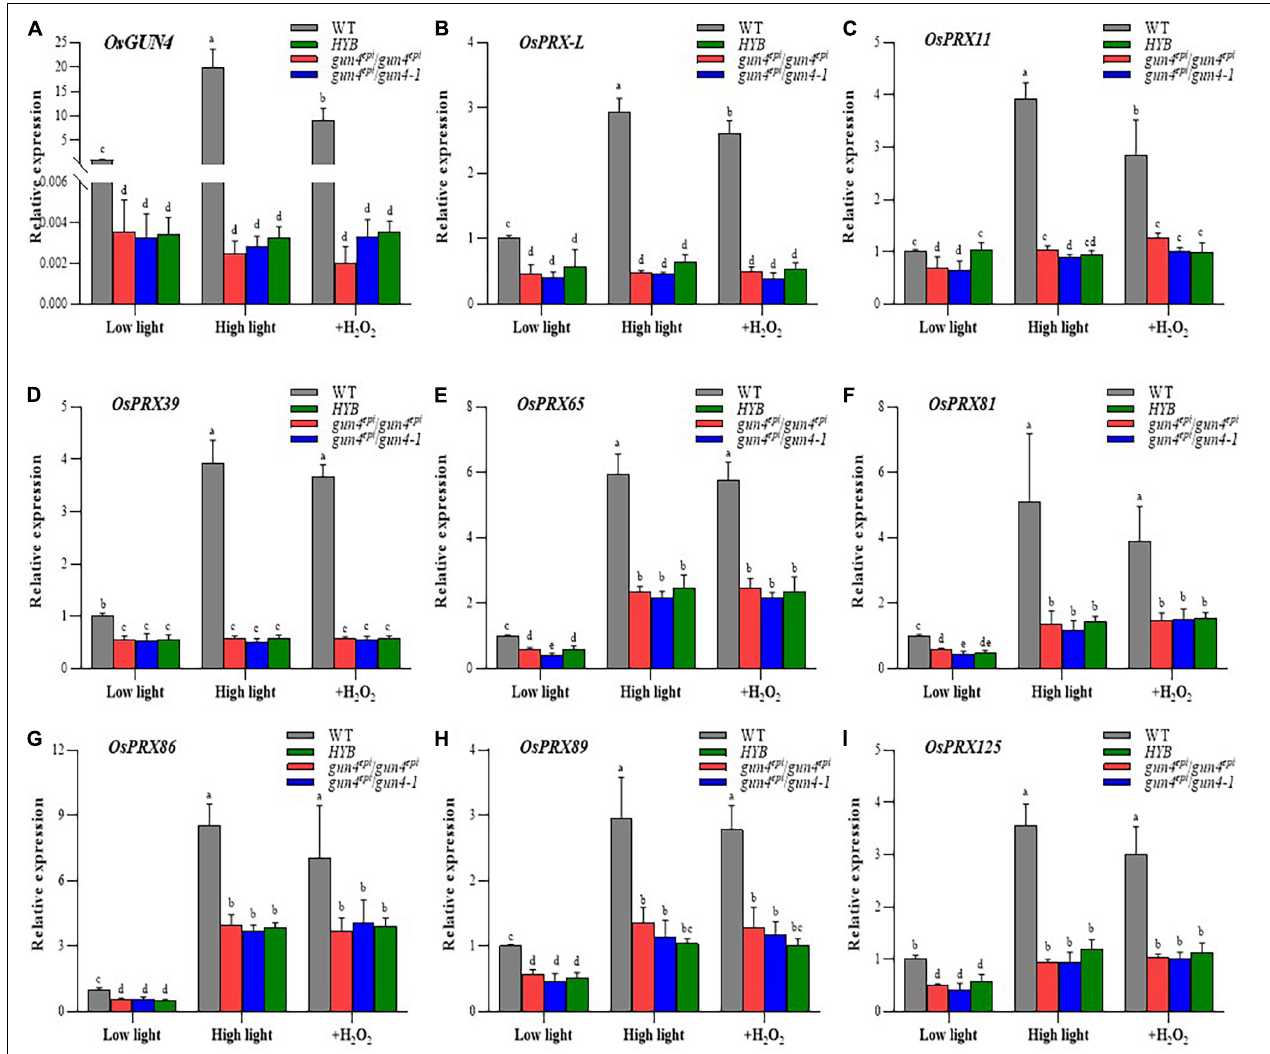
FIGURE 6 | Relative expression levels of OsGUN4 and 8 peroxidase-encoding genes. Relative expression levels of OsGUN4 (A) and 8 peroxidase (PRX)-encoding genes (B–I) in 35-day-old seedlings. WT, wild-type variety LTB; HYB, the epigenetic OsGUN4 mutant LTB ( gun4 epi / gun4 epi ) of LTB; gun4 epi / gun4 epi and gun4 epi / gun4-1 are F 2 seedlings derived from the gun4 epi / gun4-1 F 1 plants. Seedlings were grown under low (100 µ mol m − 2 s − 1 photons) or high (1000 µ mol m − 2 s − 1 photons) light conditions, or in medium with 1 mM exogenous H 2 O 2 (+H 2 O 2 ) under low light condition. Expression levels are reported relative to that of the WT grown under low light, which was assigned a value of 1. Values are means ± SD ( n = 6) and analyzed for significant differences by two-way ANOVA followed by the Tukey’s multiple comparison test, P < 0.05. For more detail of seedling growth, see M&M.